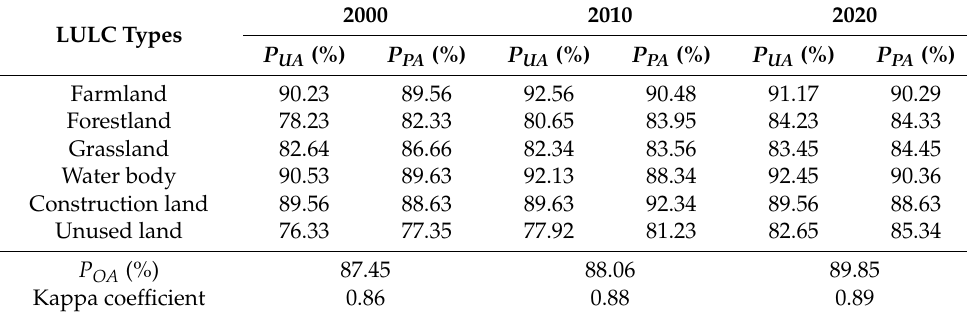
Table 4. The patterns of interaction